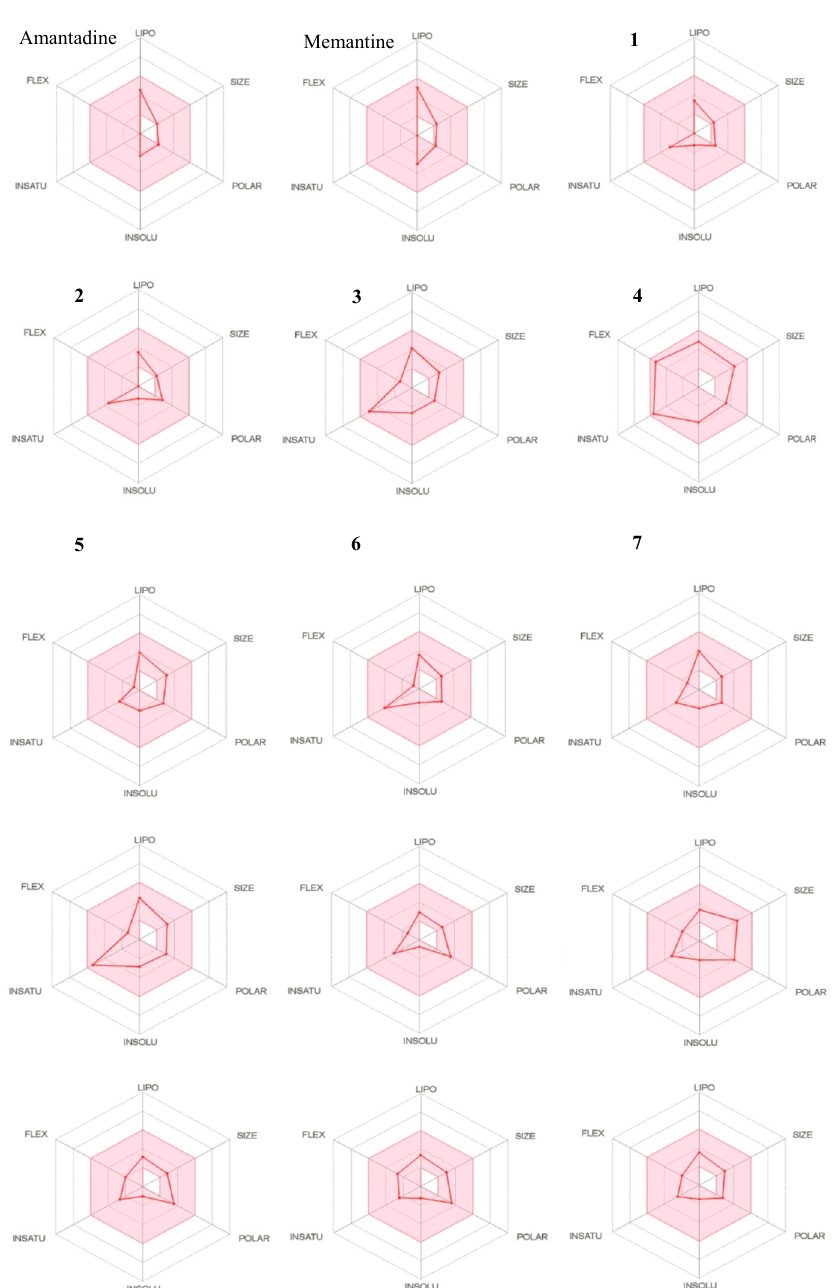
Figure 9. The bioavailability radar chart for amantadine, memantine and compounds 1 – 13 .